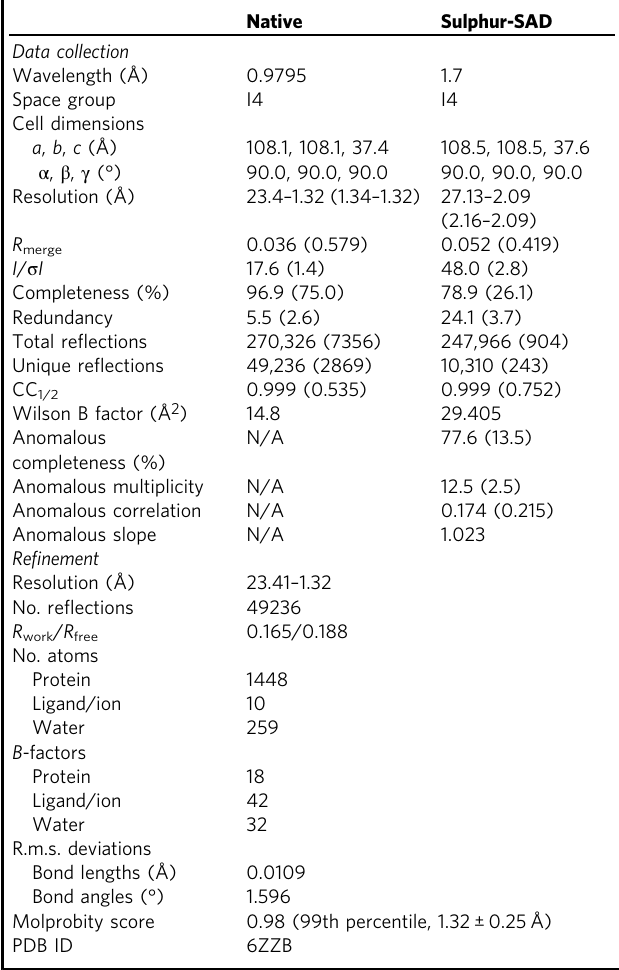
Table 1 Data collection, phasing and re fi nement statistics for